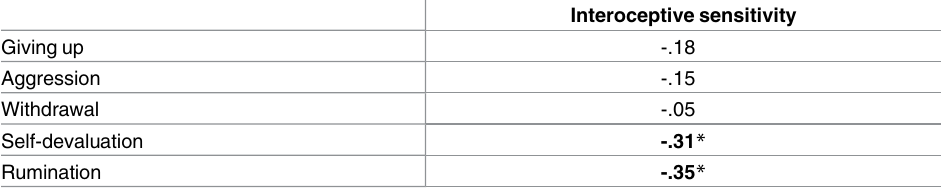
Table 4. Follow-up correlations between interoceptive sensitivity and the subscales of maladaptive emotion regulation.